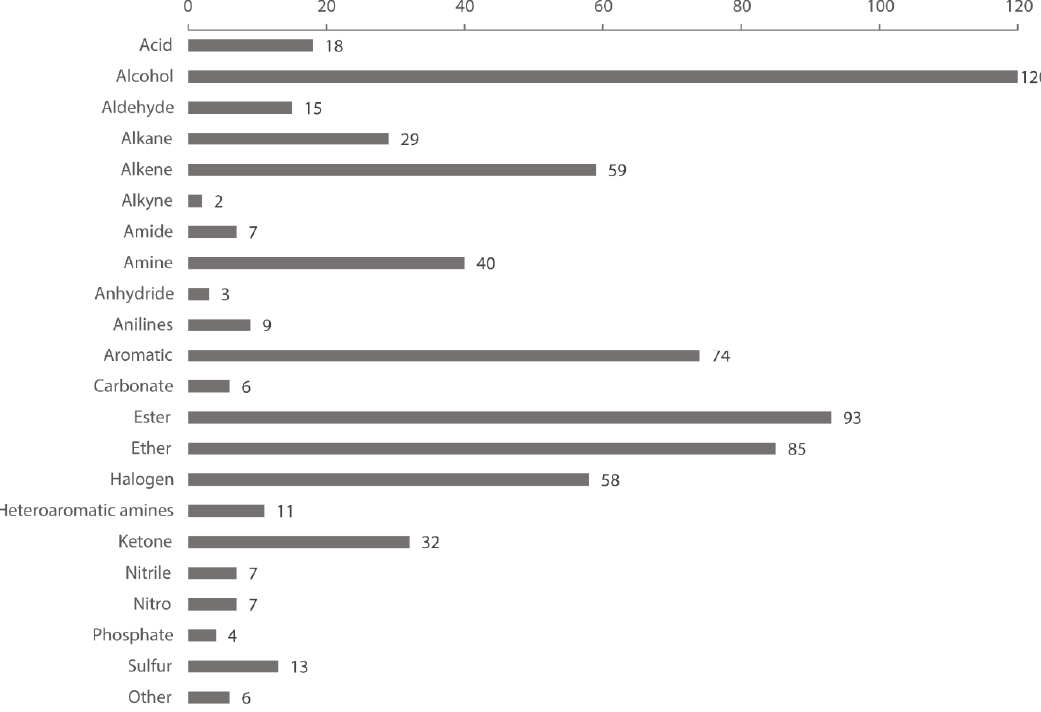
Figure 13. Functional groups in the dataset.